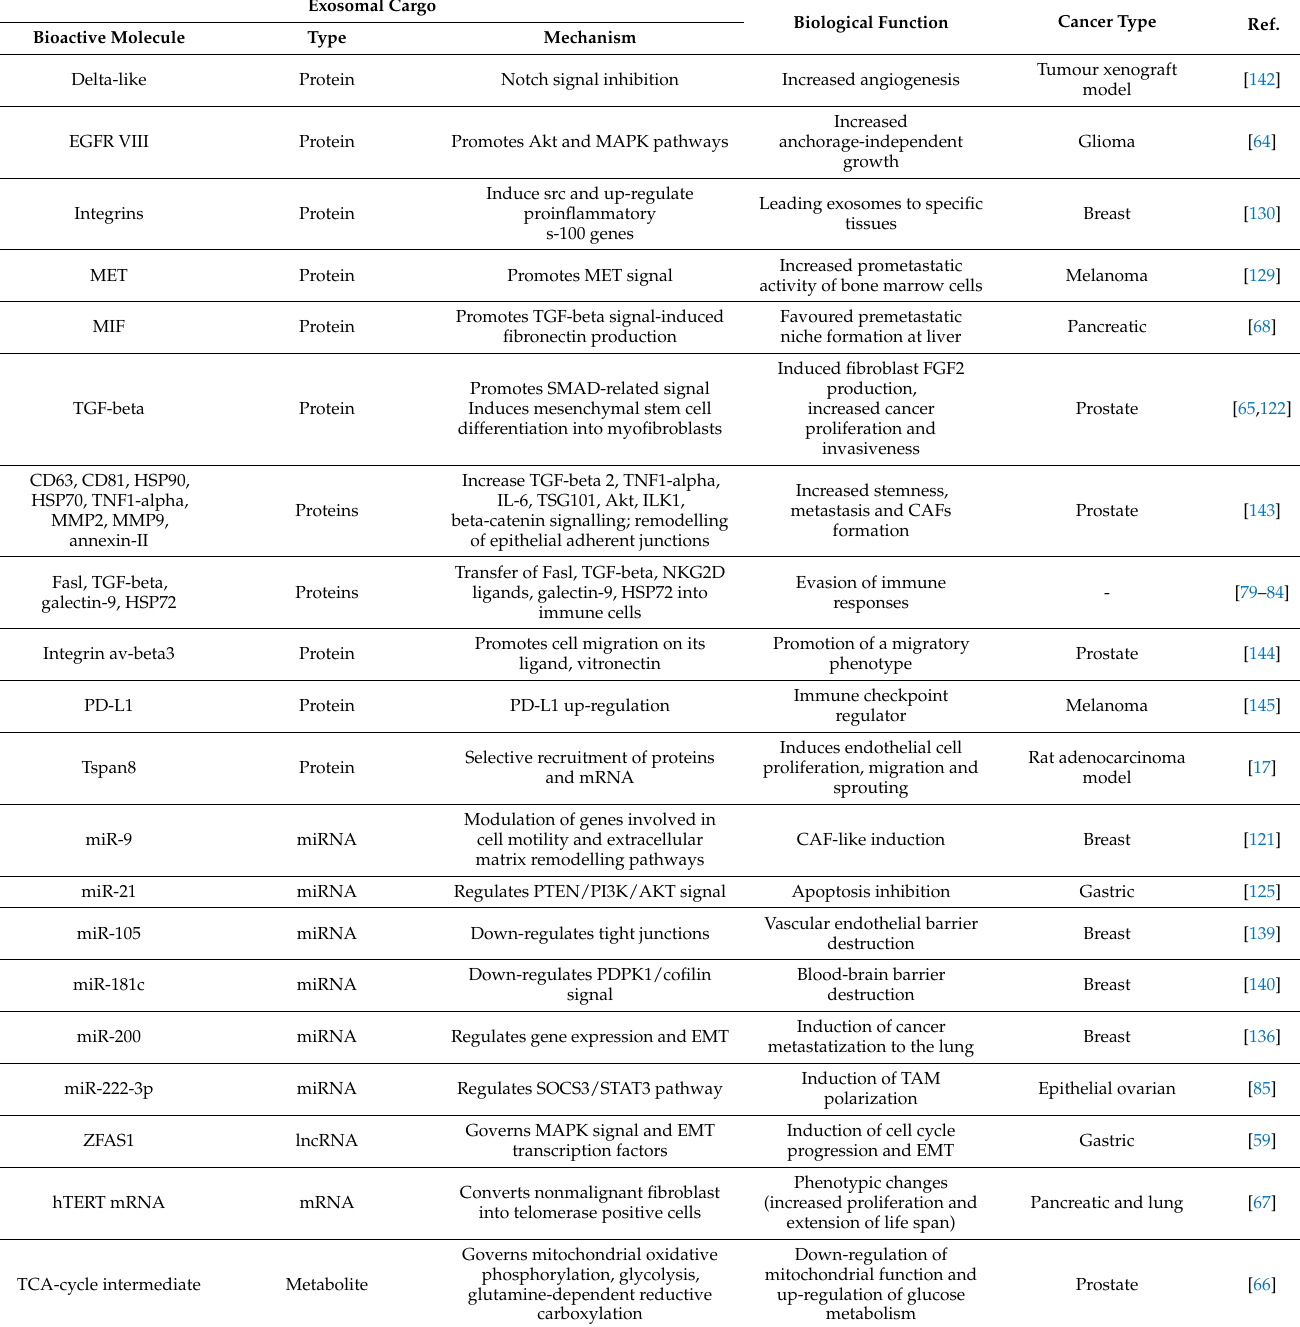
Table 1. Role that some bioactive molecules play in cancer evolution as exosomal